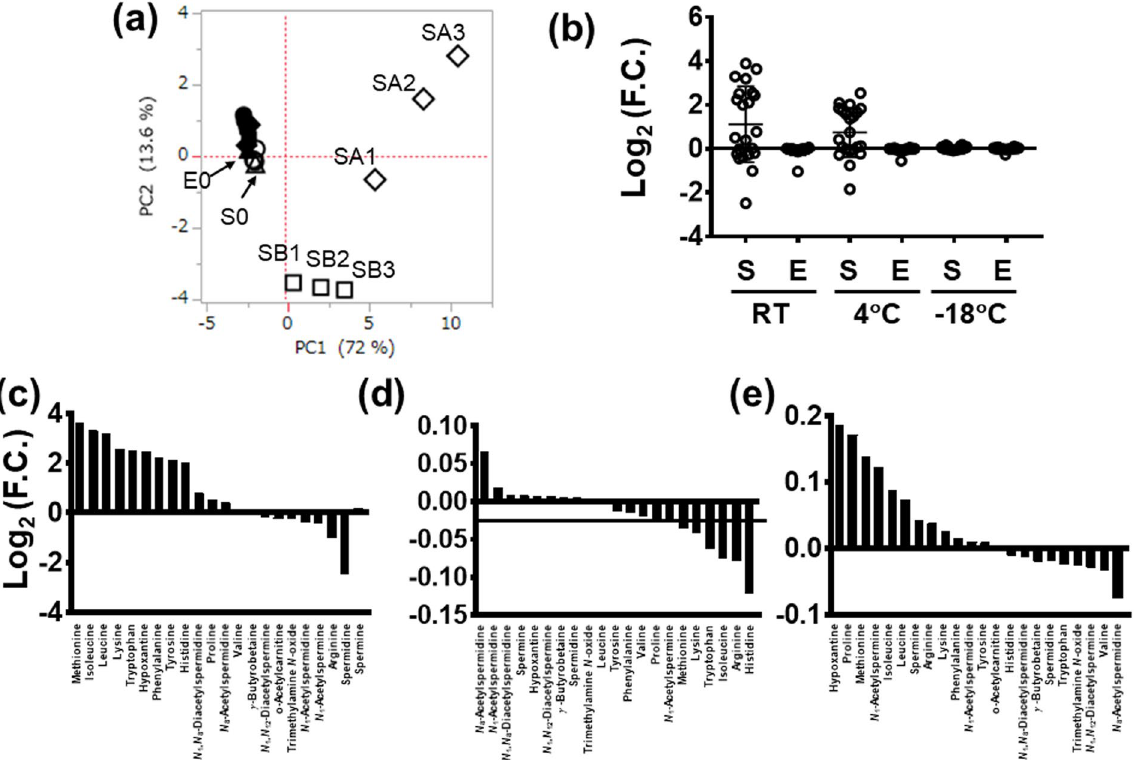
Figure 4. Changes in metabolite concentrations in the long-term storage test. ( a ) Score plots of principal component (PC) analysis. The PC1 and PC2 indicated the first and the second PC. The contributions for PC1 and PC2 were 72.0 and 13.6%, respectively. Filled and open plots indicated samples adding ethanol and internal standards (IS) or not. Labels corresponded to Fig. 1b. ( b ) Log 2 values of fold change (F.C.) of metabolite concentrations of samples after 8 days. One plot measures one metabolite. S and E indicate samples without and with adding ethanol; RT: room temperature. ( c ) Log 2 of F.C. in saliva samples without ethanol stored at RT, corresponding to SA3/S0 in Fig. 1b. ( d ) Log 2 of F.C. in saliva samples with ethanol stored at RT, corresponding to EA3/E0 in Fig. 1b. ( e ) Log 2 of F.C. in saliva samples without ethanol stored at − 18 °C, corresponding to SC3/S0 in Fig.